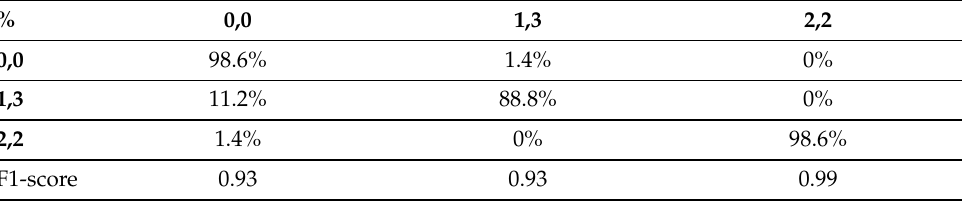
Table 6. Model’s confusion matrix and F1-score for the selected locations ( ( 0,0 ) , ( 1,3 ) , and ( 2,2 ) ). Data from